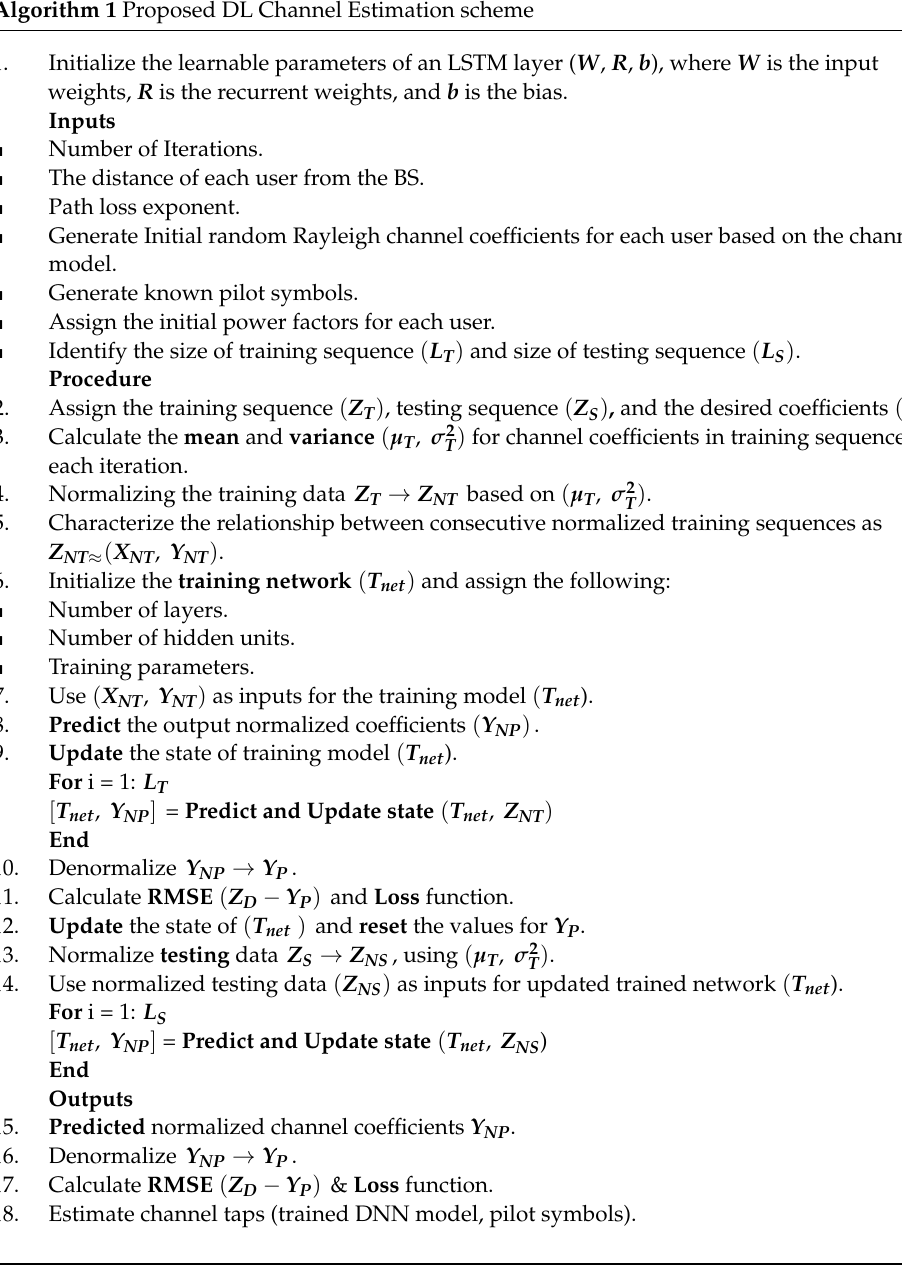
Algorithm 1 Proposed DL Channel Estimation